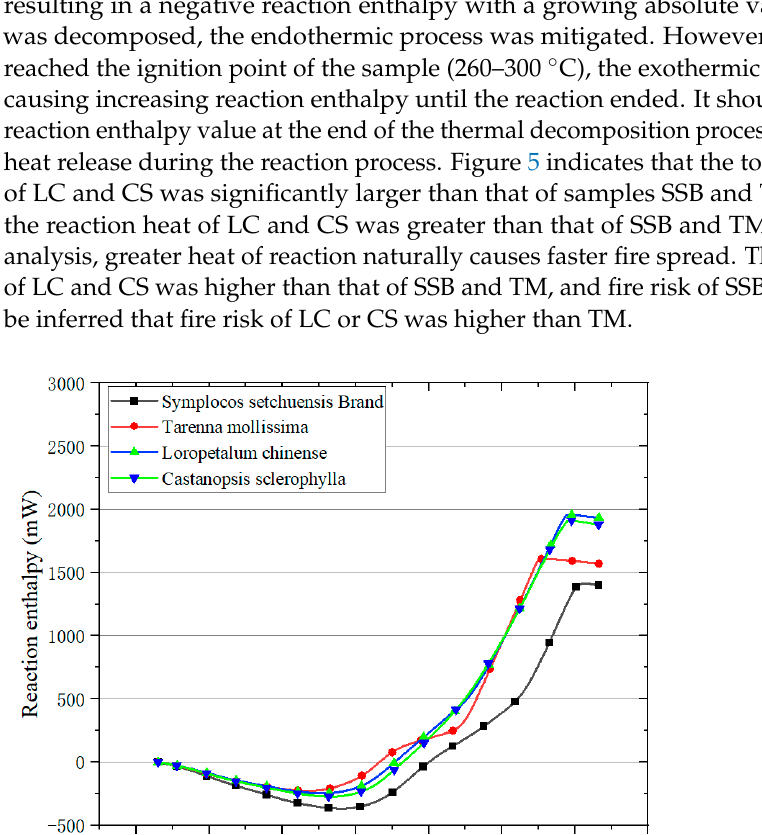
Table 3. Results of pyrolysis kinetics of DSC.